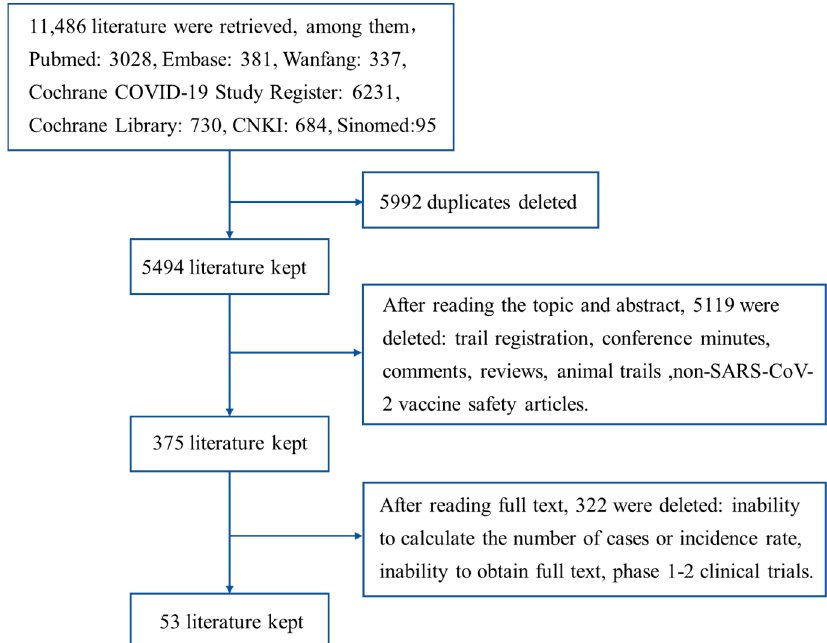
Figure 1. Literature screening process.